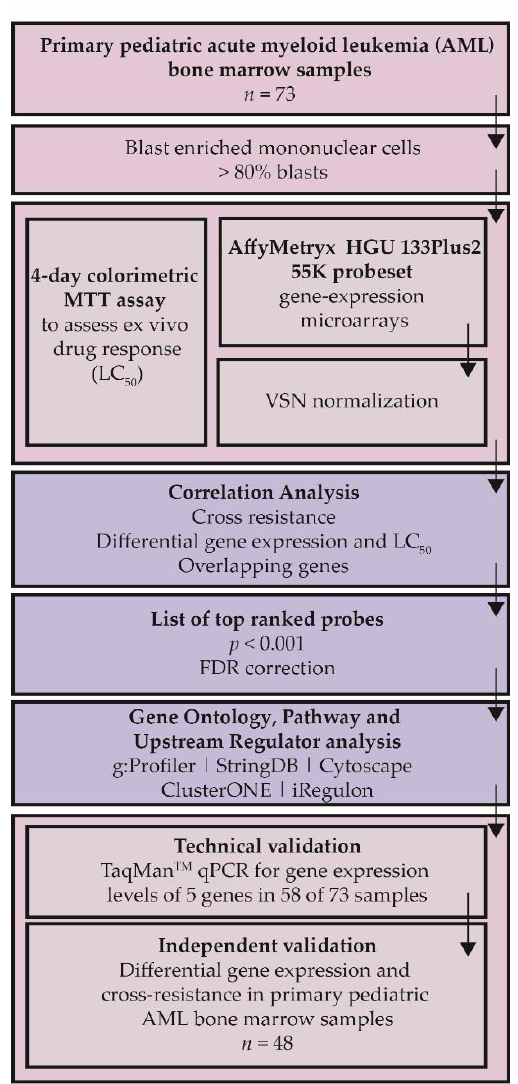
Figure A1. Schematic overview of analyses. Mononuclear cells were isolated from 73 primary pediatric AML samples at initial diagnosis. These mononuclear cells were either tested for Ex Vivo resistance towards Ara C, DNR, VP16 and 2-CdA or they were used for gene expression microarray. Technical validation was performed on an independent set of 48 primary AML samples.